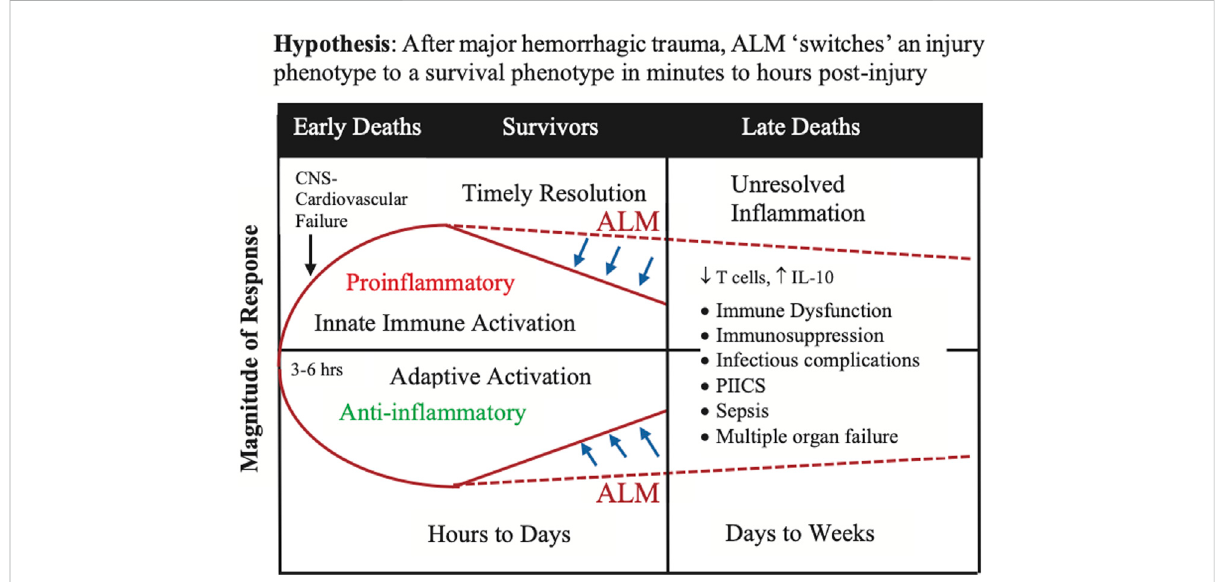
FIGURE 7 The ‘ switch ’ hypothesisproposesthatALMtherapytransitionstheinjuryphenotypetoasurvivalphenotypeinthe fi rstfewminutestohoursafter major trauma. The switch involves re-setting or rebalancing the innate immune and in fl ammatory responses to the surge and ongoing releases of DAMPs,andotherdamagesignals,intothecirculationfromthetrauma.Implicittothehypothesisistheassumptionthatthehyperacuteimmuneand in fl ammatory events that occur in fi rst few minutes to hours following a major trauma pre-determine the trajectory of the later immune and in fl ammatoryresponses andoutcome.Timely resolution oftheimmune and in fl ammatory ‘ storms ’ appears tobekey.Althoughthemechanismsare unknown, one potential target are monocytes which have recently been shown to sense injury-released DAMPs via the AIM2 in fl ammasome and inducetheextrinsiccelldeathofTcells(Rothetal.,2021).ALM,adenosine,lidocaineandmagnesium;CNS,centralnervoussystem;DAMP,damage- associated molecular pattern; IL, interleukin; PIICS; Persistent In fl ammation, Immunosuppression and Catabolism